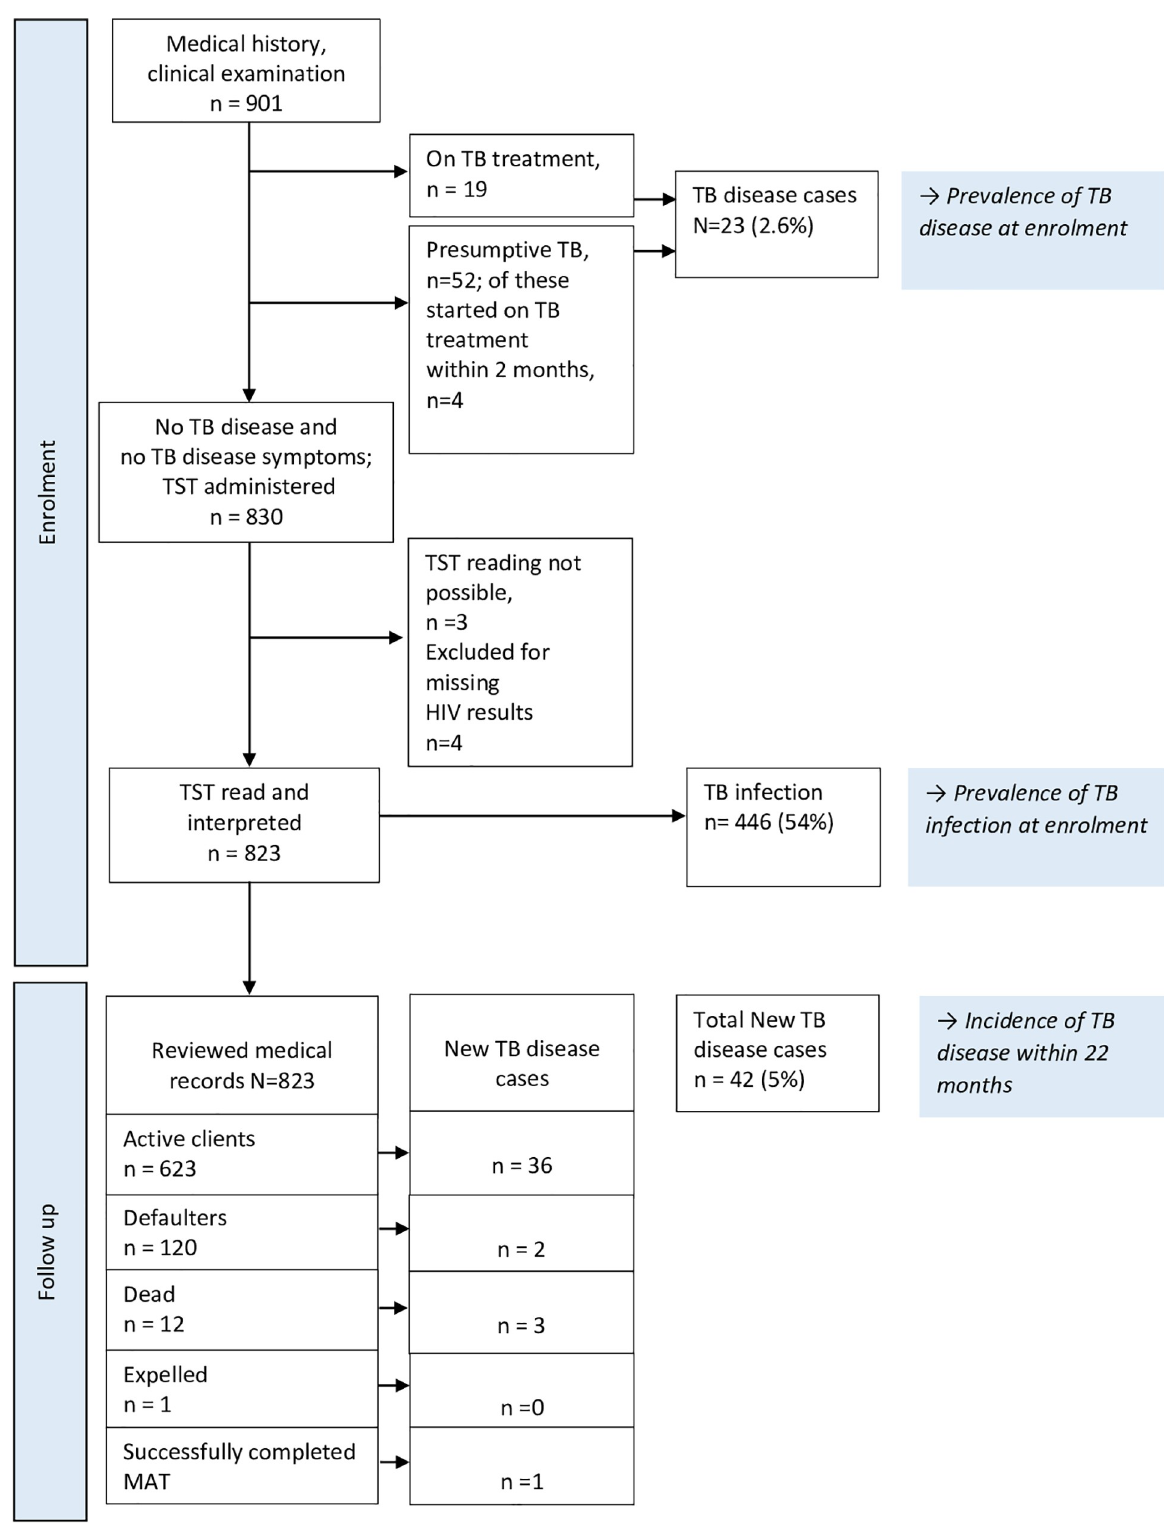
Fig 1. Patient flow diagram.